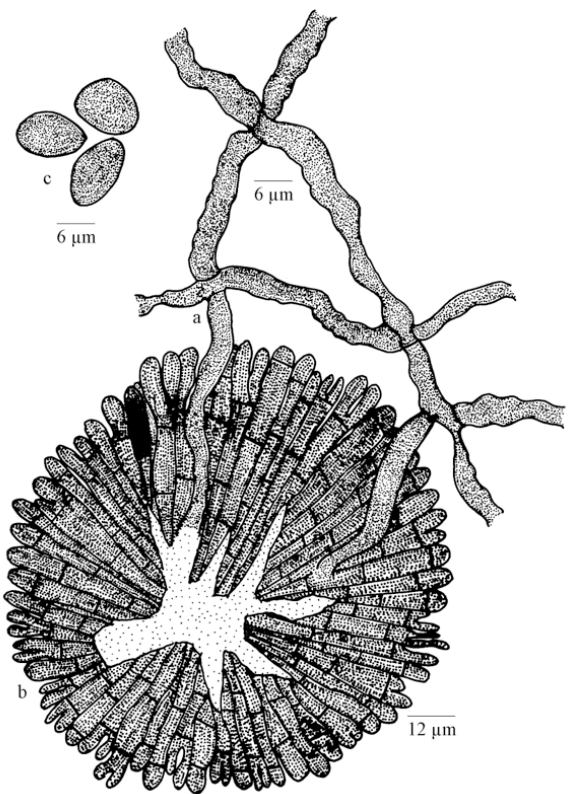
Figure 179. Asterostomula pavettae a - Mycelium; b - Pycnothyrium; c -